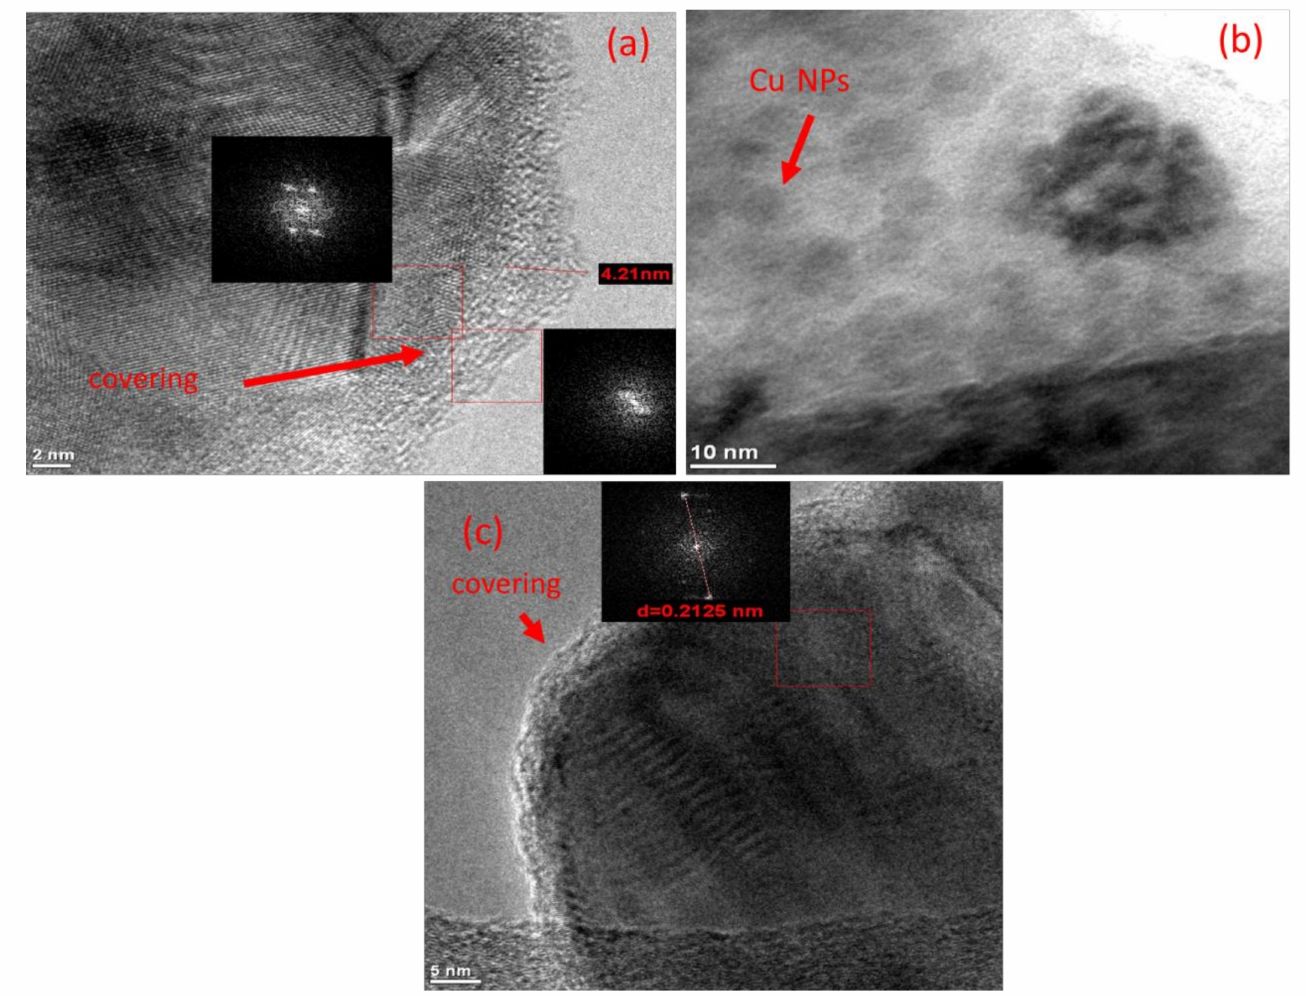
Figure 4. TEM micrographs of ( a ) Cu-PEI NPs, ( b ) Cu-PEI/AABT NPs, and ( c ) Cu-PEI/AAM